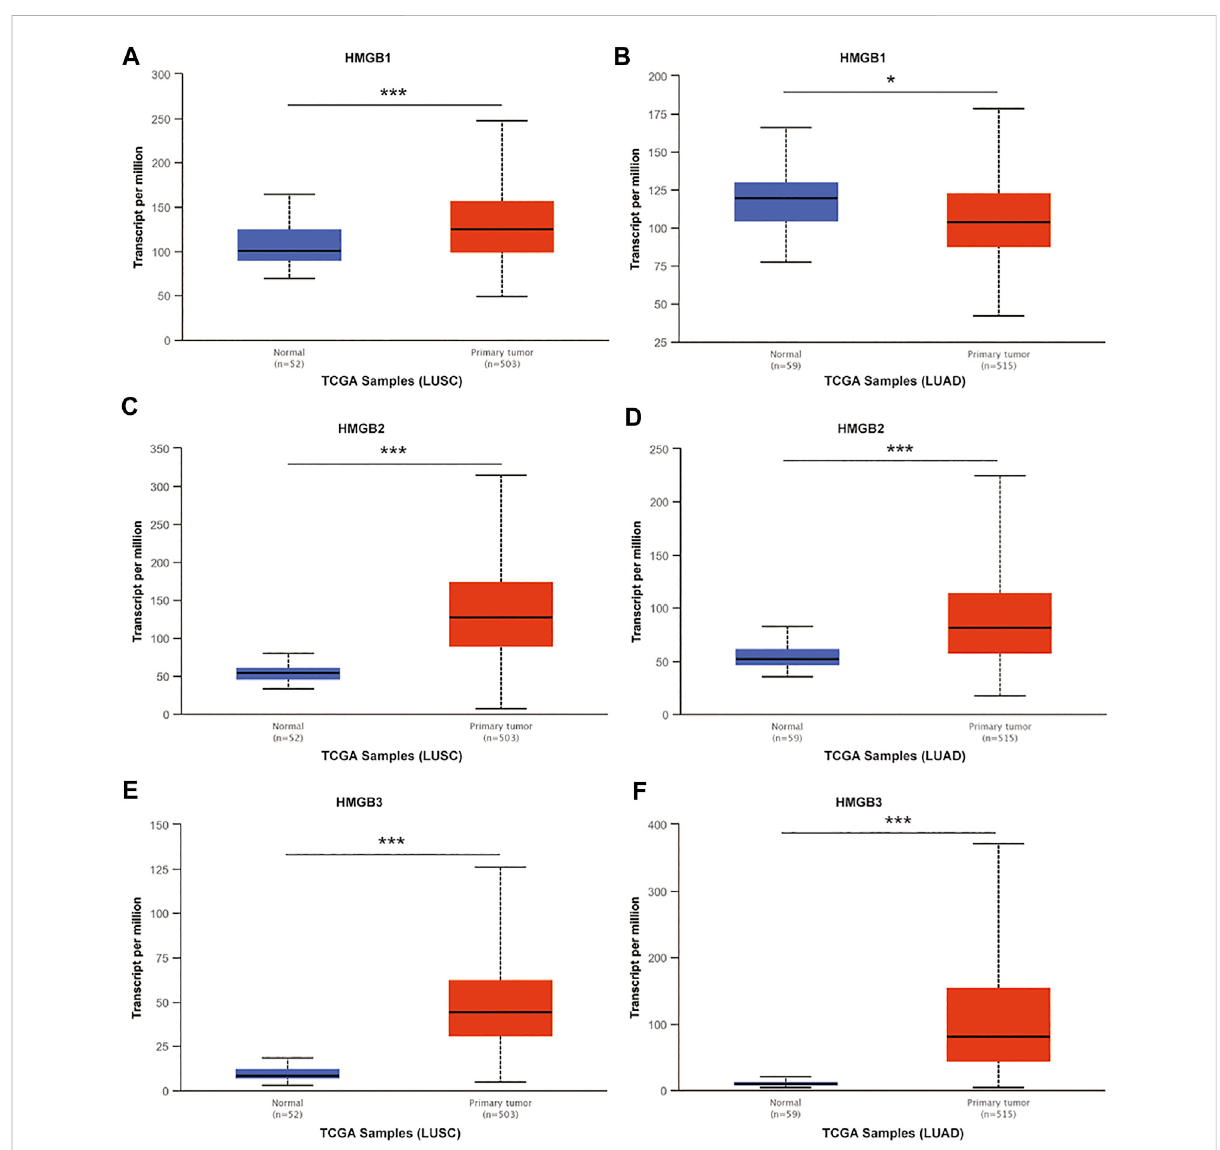
FIGURE 2 The mRNA expression of HMGB family members in NSCLC tissues and normal lung tissues (UALCAN). mRNA expressions of HMGB1/2/3 were elevated in LUSC tissue compared to normal samples (A,C,E) . HMGB2/3 was higher in LUAD tissue than in normal lung tissues (D,F) , while the expression level of HMGB1 was lower in the LUAD tissue than in normal lung tissue (B) . *** p < 0.001, * p <